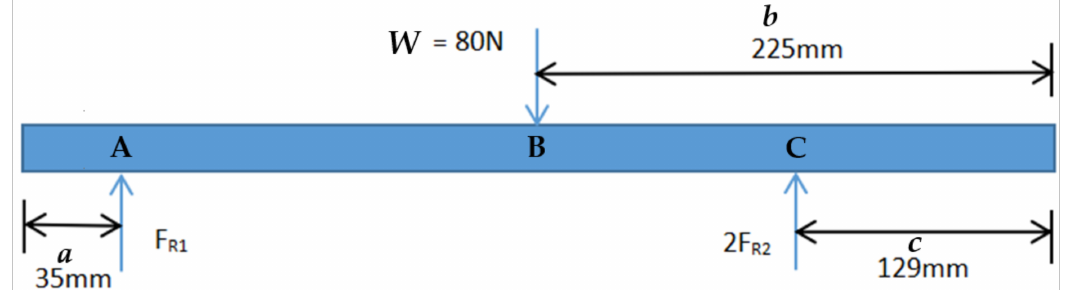
Figure 3. Free-body diagram of the lawnmower.